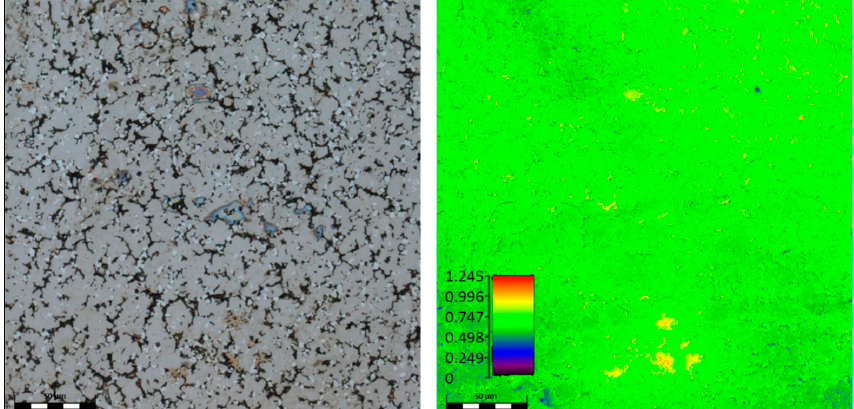
Figure 10. Confocal image of the Mn 0.5 TiCuAlCr surface after corrosion test.